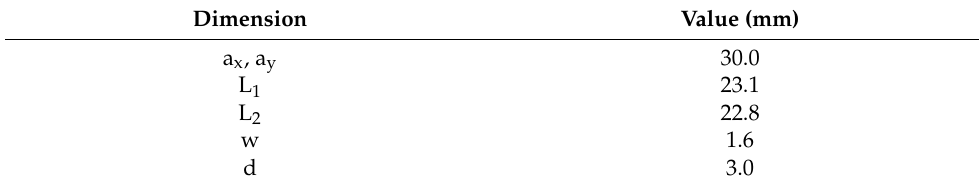
Table 1. Dimensions of the metasurface unit, as shown in Figure